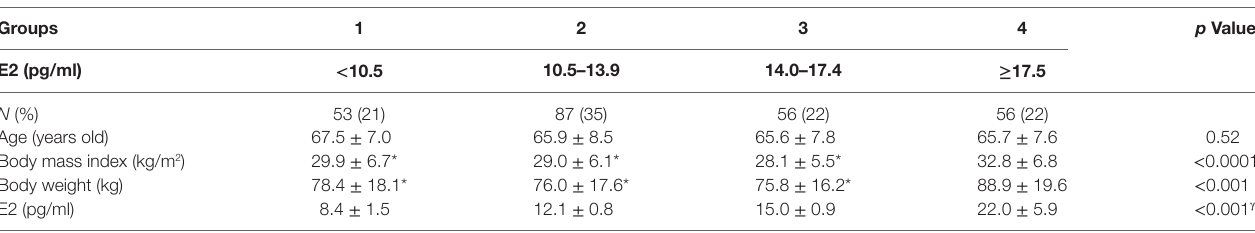
TaBle 1 | Population characteristics according to circulating estradiol (E2).